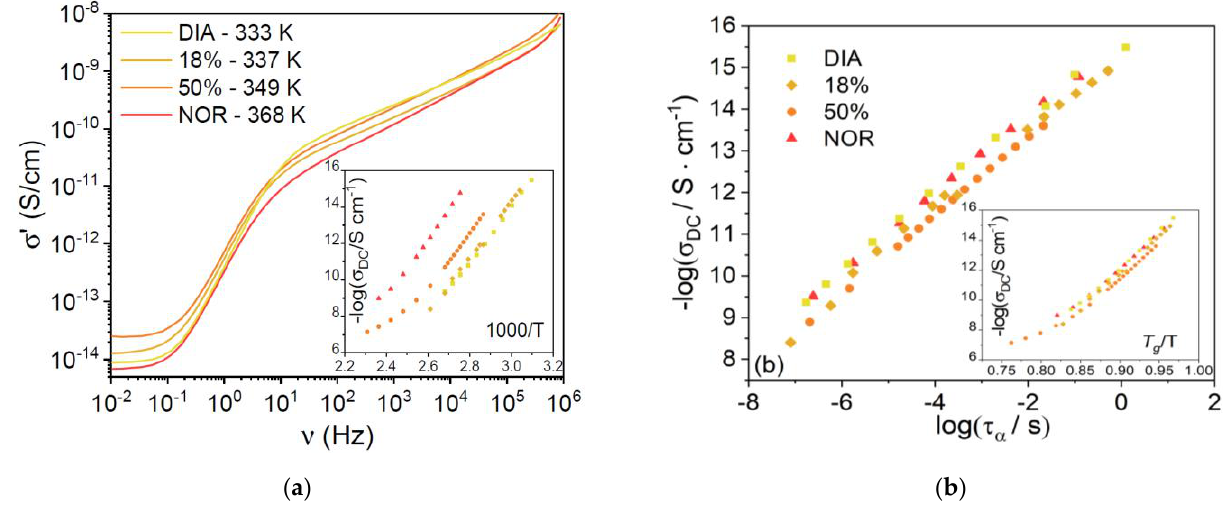
Figure 5. ( a ) Real part of the complex conductivity function against the frequency, at a selected temperature for pure liquid NOR and DIA and for the eutectic and equimolar liquid mixtures. Temperatures are indicated in the legend. Inset: Arrhenius plot of the temperature dependence of the DC conductivity ( σ DC ) of the same samples. ( b ) Logarithm of σ DC of the same samples against their structural ( α ) relaxation time. Inset: Angell plot of σ DC